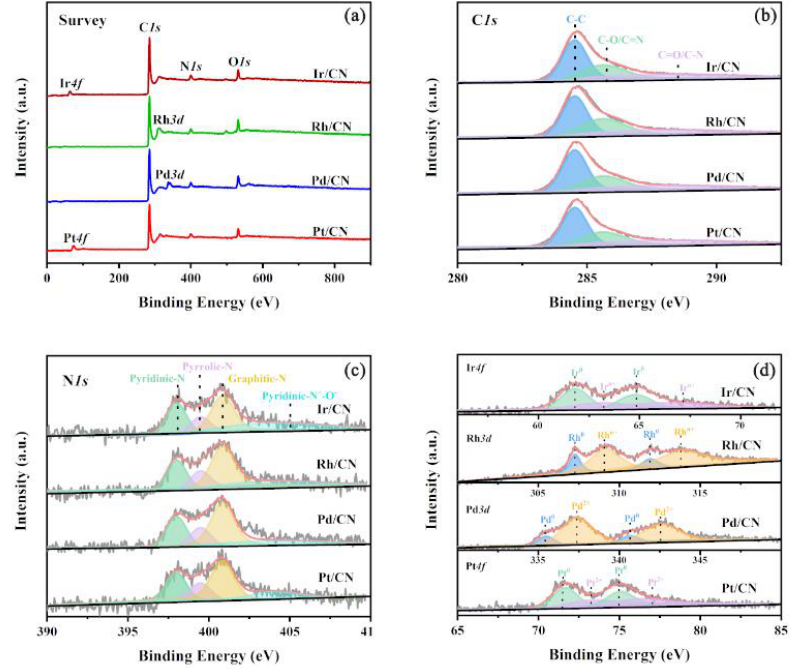
Figure 3. ( a ) XPS spectra, ( b ) C 1s spectra, ( c ) N 1s spectra and ( d ) Pt 4f , Pd 3d , Rh 3d and Ir 4f spectra of the M/CN (M = Pt, Pd, Rh and Ir) catalysts.